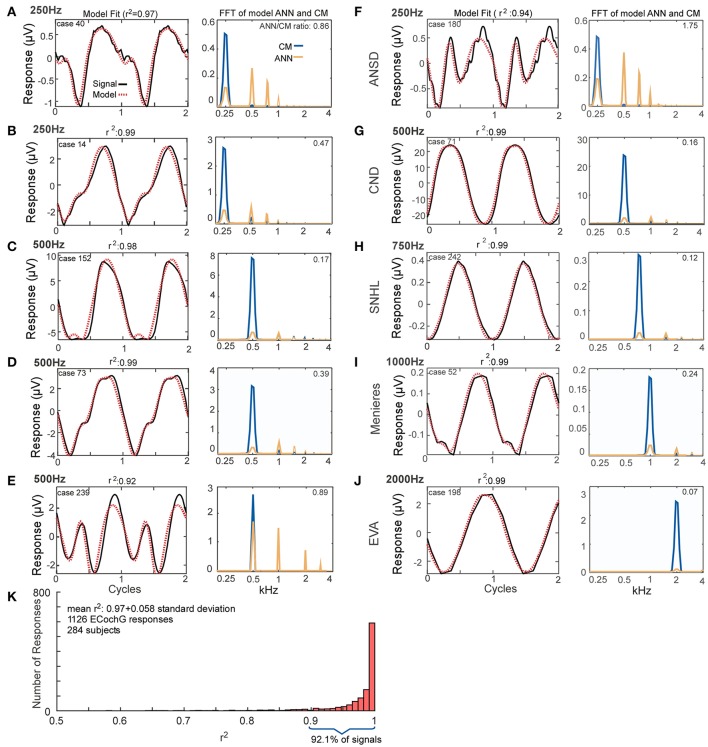
Model fits to ECochG responses in human subjects. (A–E) Responses from different subjects to 250 Hz (A,B) or 500 Hz (C–E) show that the output of the model (left panels, red, dotted line) is able to reproduce the wide variety of waveforms seen in human CI subjects (solid black lines). From the model, the spectra of the CM and ANN used to produce the fit can be produced (right panels). For each case the linear fit between the two curves was described by the r2 value, and the ANN/CM ratio is given for the spectra. (F–J) Similar to the previous examples, except these cases are from subjects with different hearing loss etiologies, to indicate the heterogeneity of causes leading to cochlear implantation (ANSD, auditory nerve spectrum disorder; CND, cochlear nerve deficiency, SNHL, unknown cause of sensineural hearing loss; Meniere's, Meniere's disease; EVA, enlarge vestibular aqueduct). The responses are shown in order of increasing stimulus frequency. The spectrum of the ANN is slightly displaced for clarity. (K) Across all recordings (n = 1,126) from 284 subjects, the model was able to fit observed ECochG signals with an mean r2 of 0.97 ± 0.058 (standard deviation).